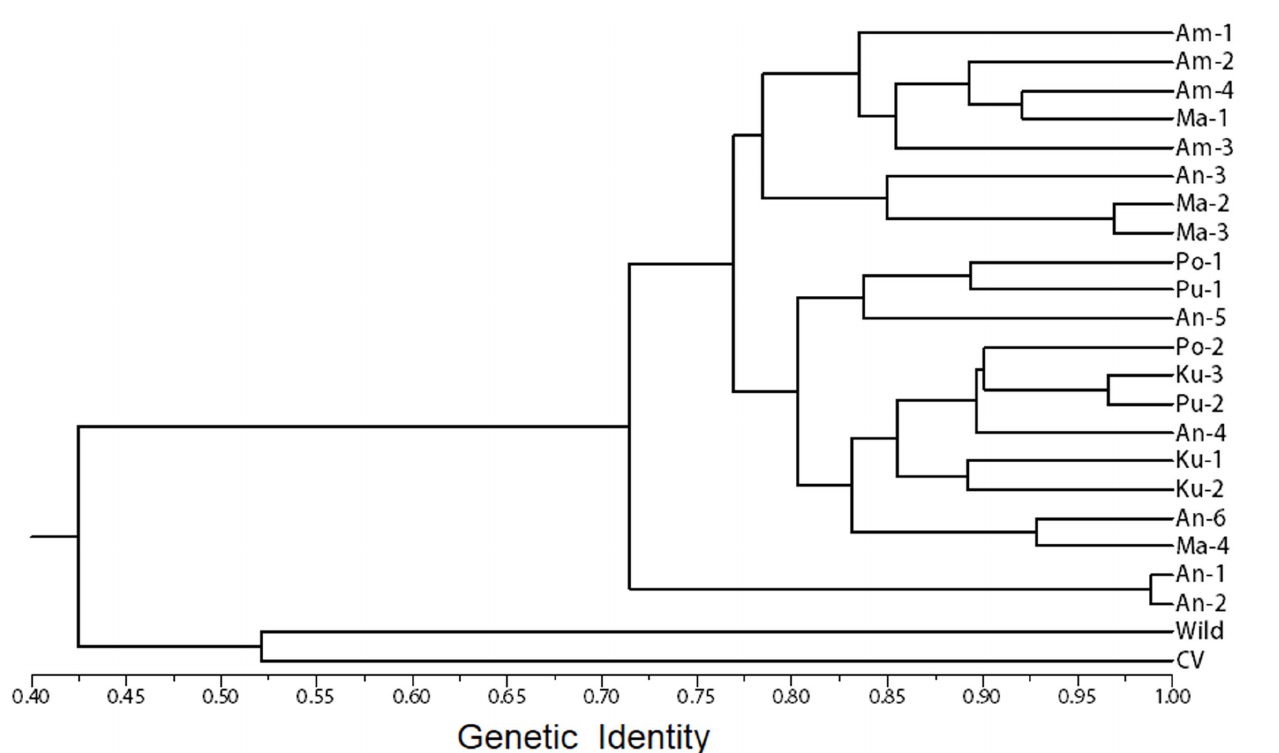
Figure 2. UPGMA dendrogram constructed based on the genetic similarity of 21 weedy rice populations. Similarity was estimated by 23 SSR loci, using cultivated (CV) and wild rice (Wild) as two reference